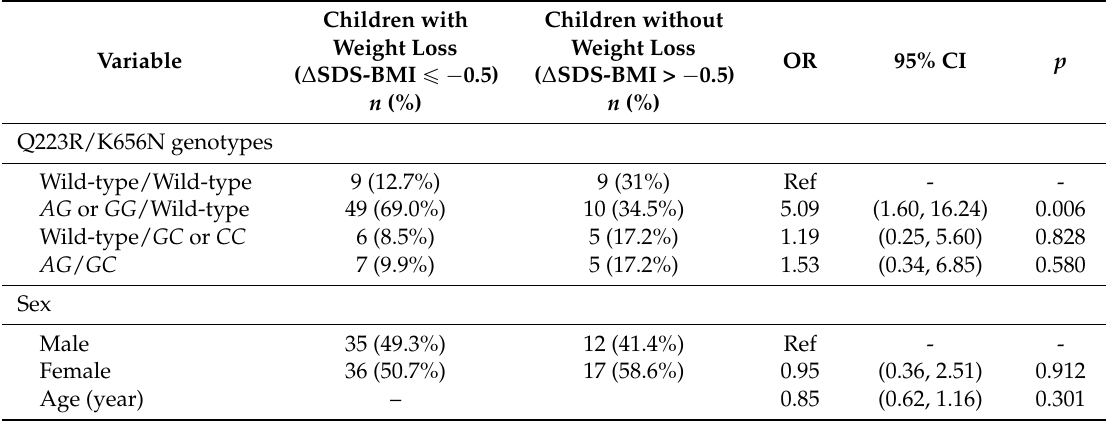
Table 3. Logistic regression model of the combined influence of Q223R and K656N LEPR